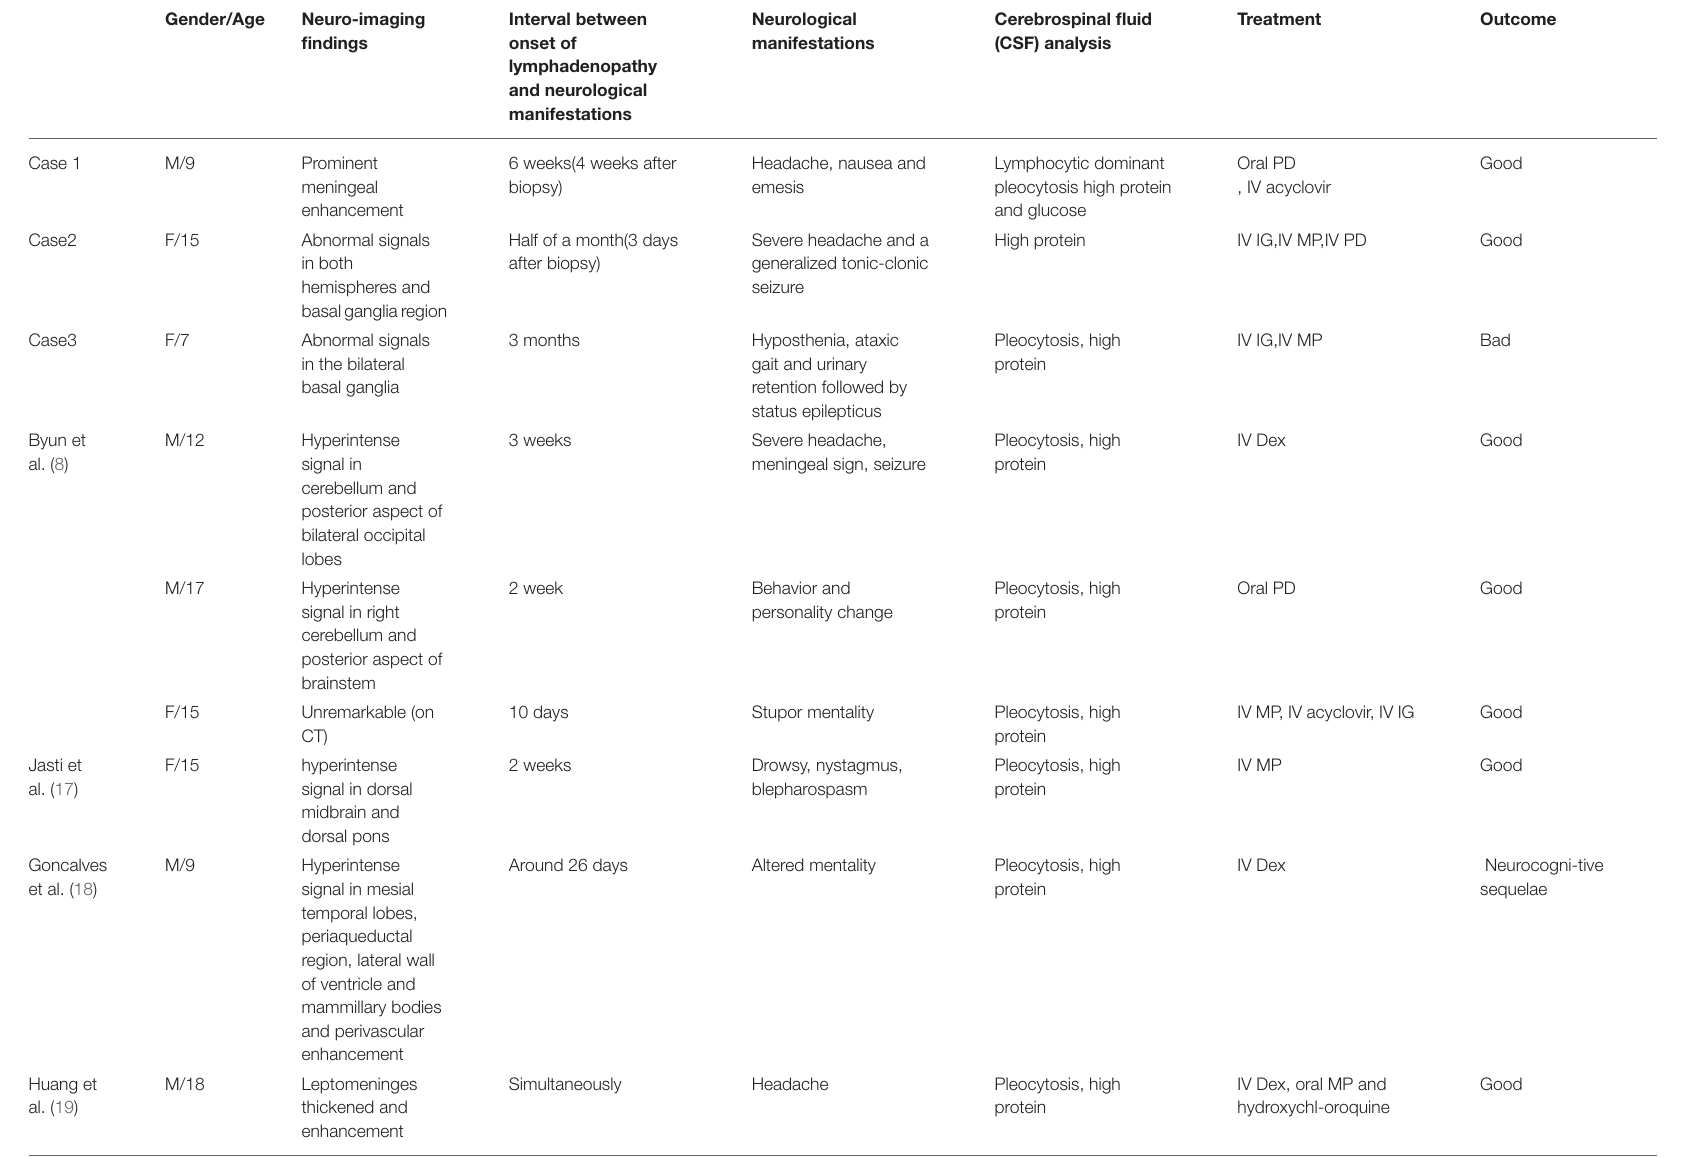
TABLE 1 | KFD with encephalopathy in children published between 2010 and 2020 in PubMed. Gender/Age Neuro-imaging Interval between findings onset